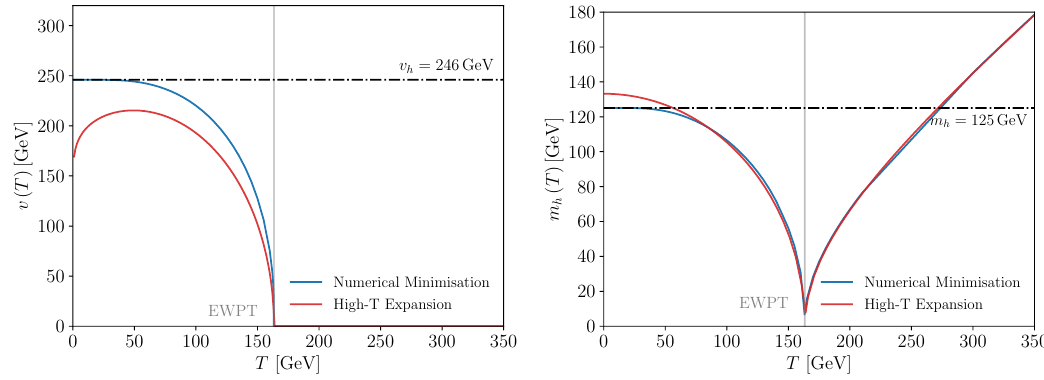
Figure 1 . The Higgs vev (left) and mass (right) as a function of temperature. The red lines correspond to results obtained by using a high-temperature expansion of the effective potential, whereas the blue lines correspond to the ones used in this work, obtained by numerical minimisation of eq. (3.1). The dashed-dotted black lines represent the zero temperature values of the Higgs vev (left) and mass (right). The vertical grey line indicates the approximate temperature of the electroweak phase